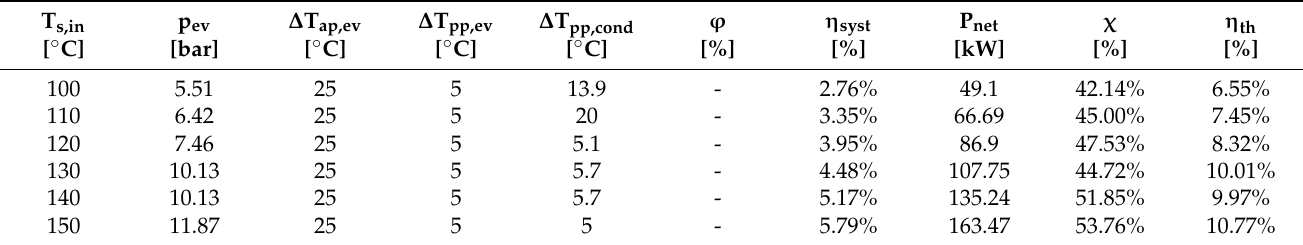
Table 2. Results of the optimization of the ORC with R245fa as working fluid for the considered heat source